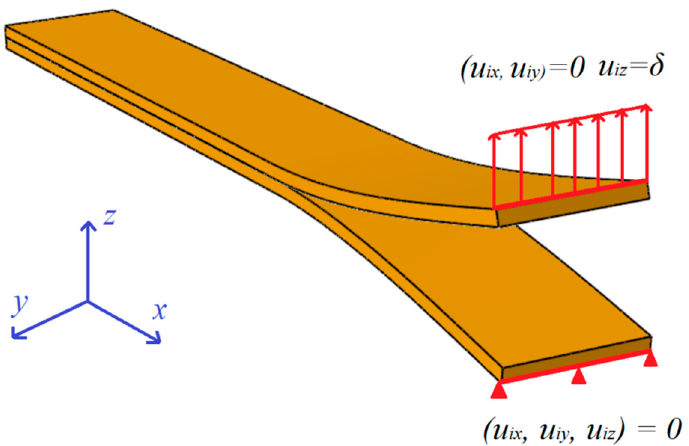
Figure 6. Initial boundary conditions.